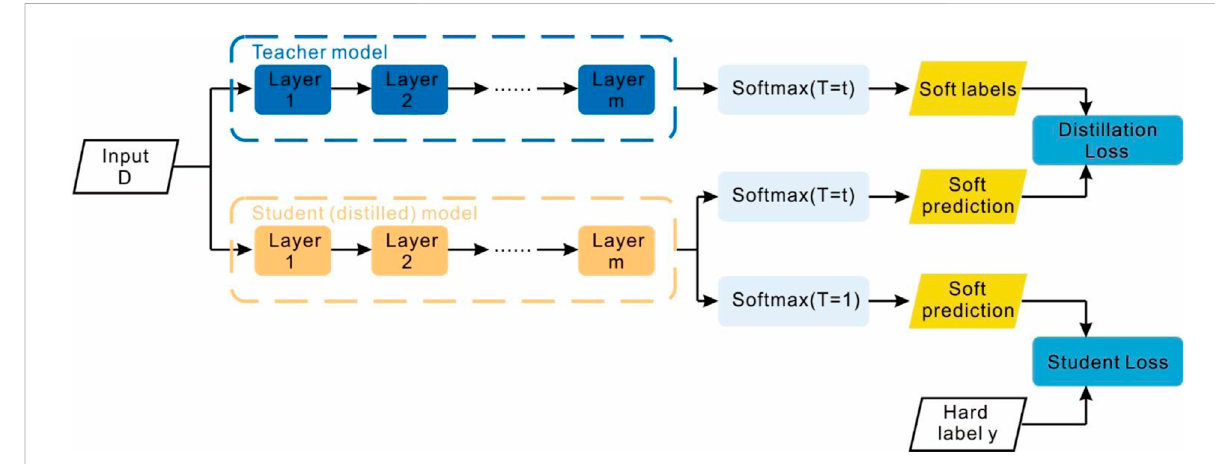
FIGURE 2 The knowledge distillation diagram (modi fi ed from